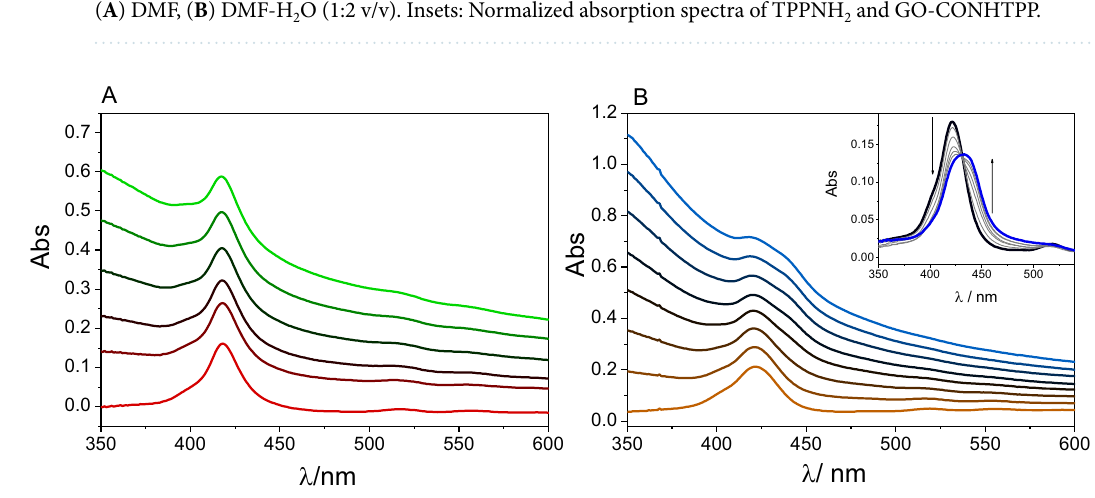
Figure 4. Absorption spectra recorded for 3 mL of 0.7 µM solution of TPPNH 2 in: ( A ) DMF with GO dispersion (0–0.066 mg mL −1 ), ( B ) DMF-H 2 O (1:2, v/v) with GO dispersion (0–0.1 mg mL −1 ). The inset highlights the Soret band region with the spectra corrected for GO